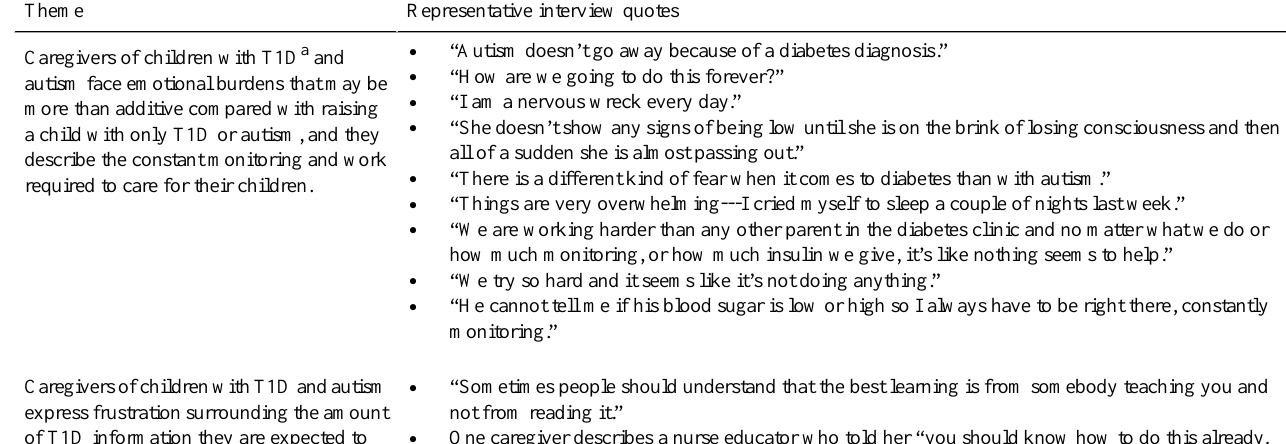
Table 3. Phase 2 themes and representative quotes from analysis of interviews. Representative interview